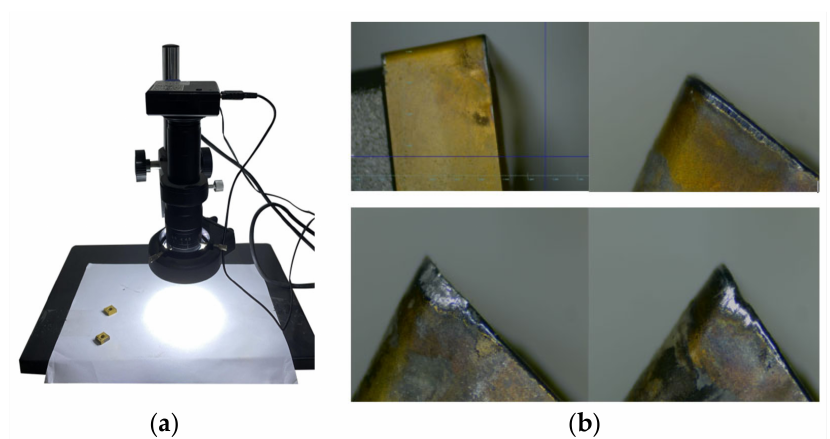
Figure 6. ( a ) Electron microscope; ( b ) wear of the tool